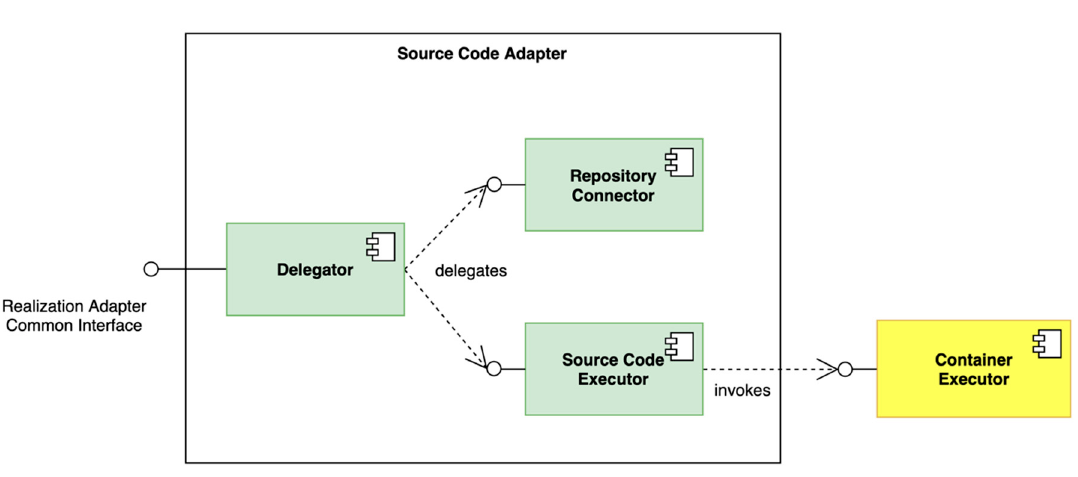
Figure 6. The Source Code Adapter.